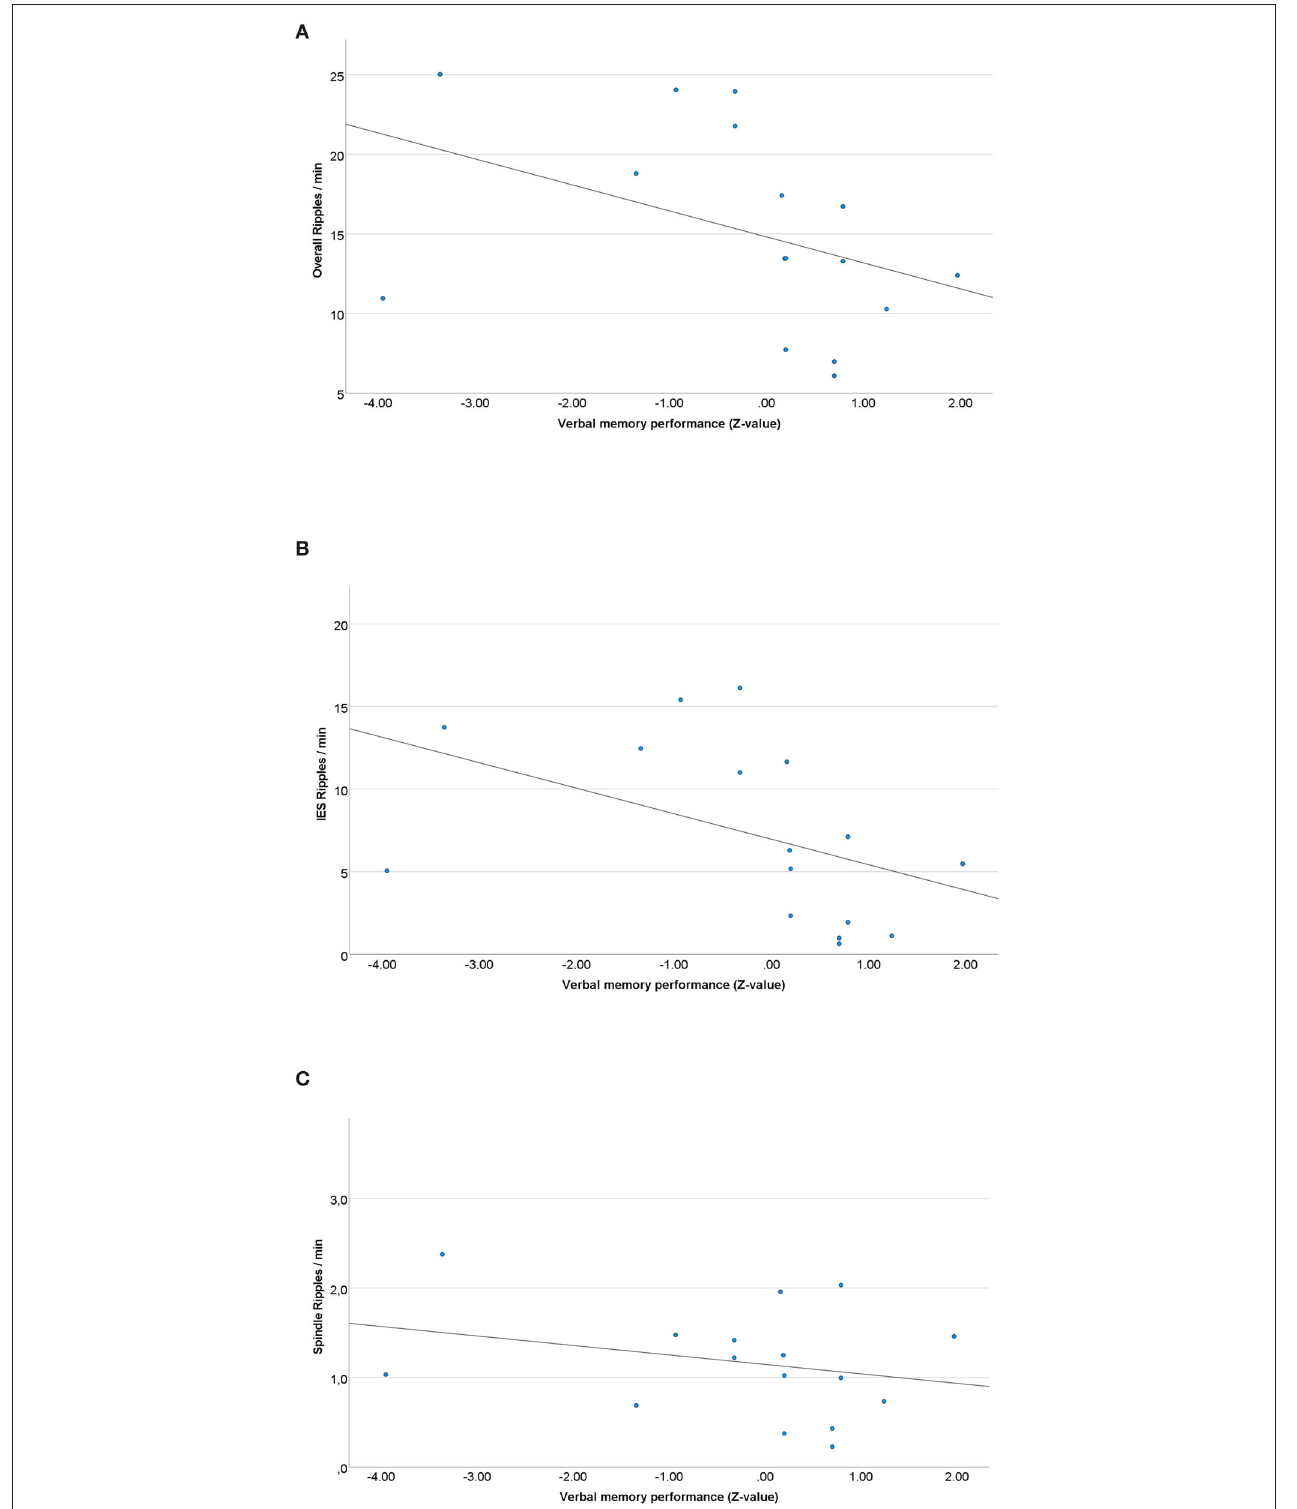
FIGURE 4 | (A) Scatterplot of the overall left mesial-temporal ripple rate and pre-surgical verbal memory results. A significant negative correlation between ripple rates and memory performance was seen (r s = − 0.475; p = 0.006). (B) Scatterplot of the left mesial-temporal IES ripple rate and pre-surgical verbal memory results. A significant negative Spearman correlation was seen (r s = − 0.458; p = 0.007). (C) Scatterplot of the left sided spindle ripple rate and pre-surgical verbal memory results. No significant Spearman correlation was seen (r s = − 0.194; p = 0.149).